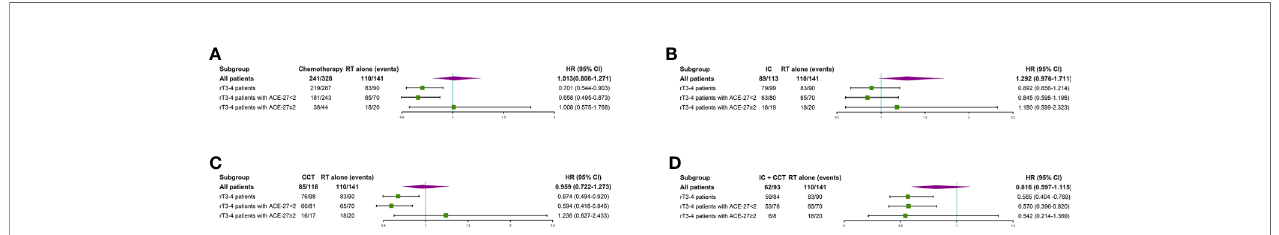
FIGURE 2 | Subgroup analyses of overall survival for patients with radiotherapy only or chemotherapy plus radiotherapy (A) , overall survival for patients with radiotherapy only or induction chemotherapy plus radiotherapy (B) , overall survival for patients with radiotherapy only or concurrent chemotherapy plus radiotherapy (C) , and overall survival for patients with radiotherapy only or induction chemotherapy plus concurrent chemotherapy plus radiotherapy (D) . IC, induction chemotherapy; CCT, concurrent chemotherapy; CI, con fi dence interval; HR,